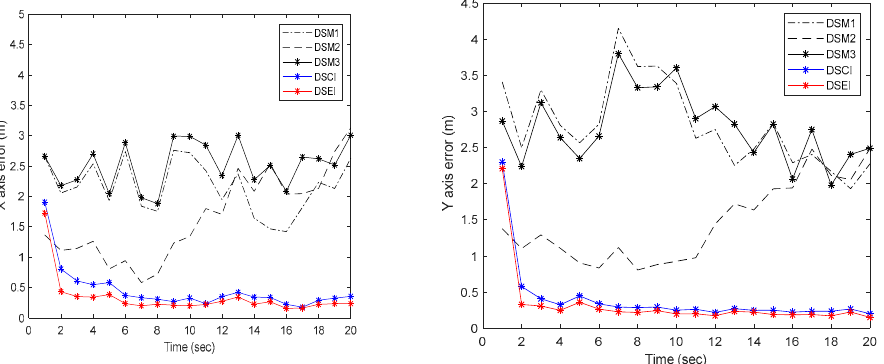
Figure 5. Comparison of errors in target tracking of positioning systems in the X -axis and Y -axis directions.